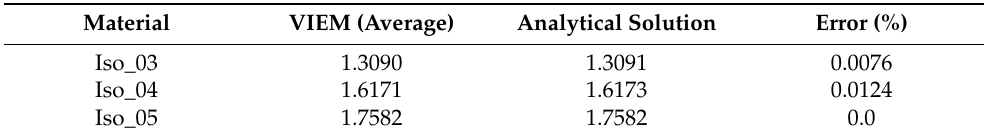
Table 7. Normalized tensile stress component ( σ xx / σ o xx ) within the isotropic spherical inclusion due to uniform remote tensile loading ( σ o xx